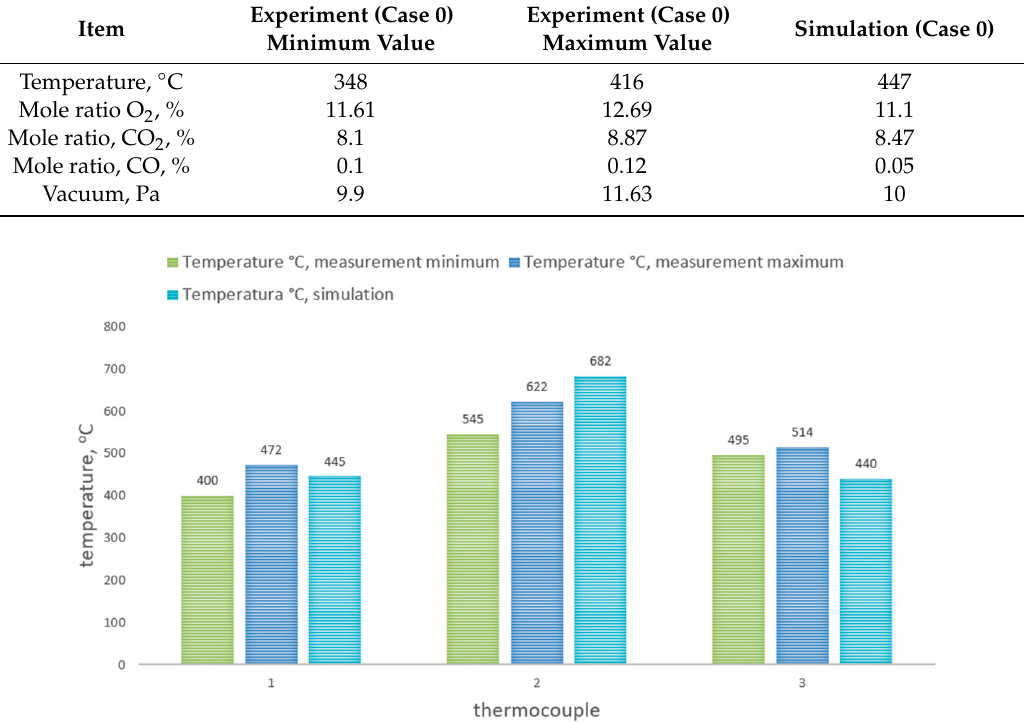
Figure 9. Temperature values (°C) comparison of the three thermocouples obtained from measurement and simulation (Case 0).